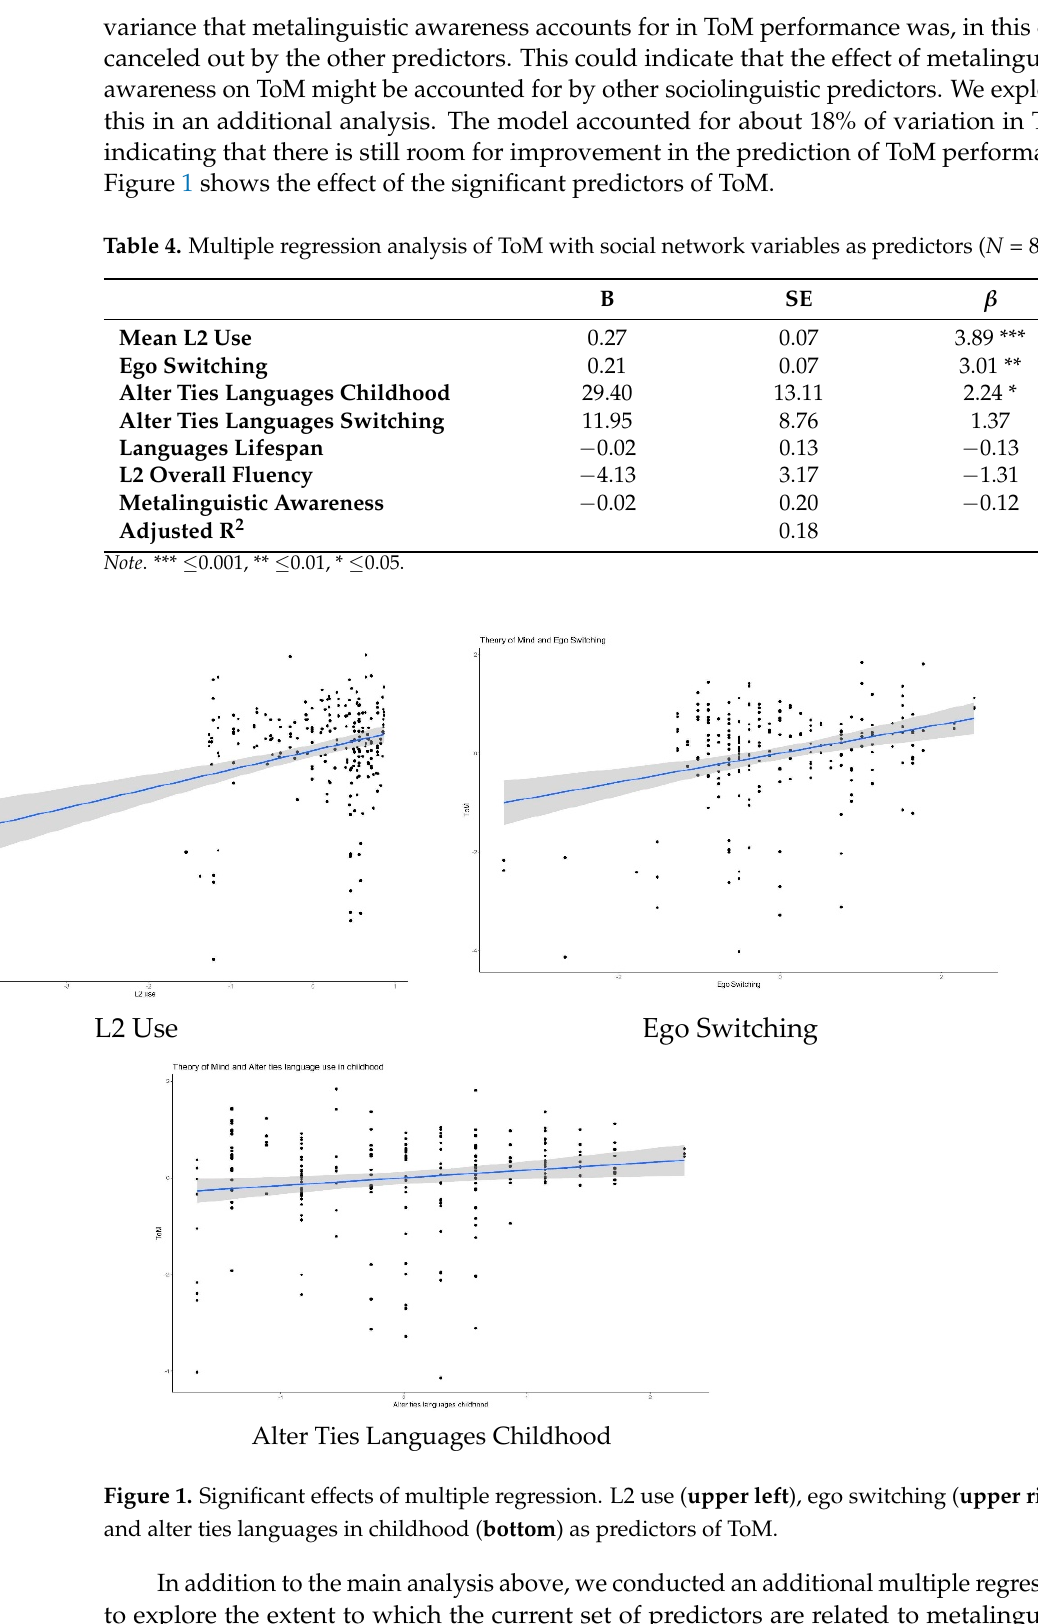
Table 4. Multiple regression analysis of ToM with social network variables as predictors ( N = 89).